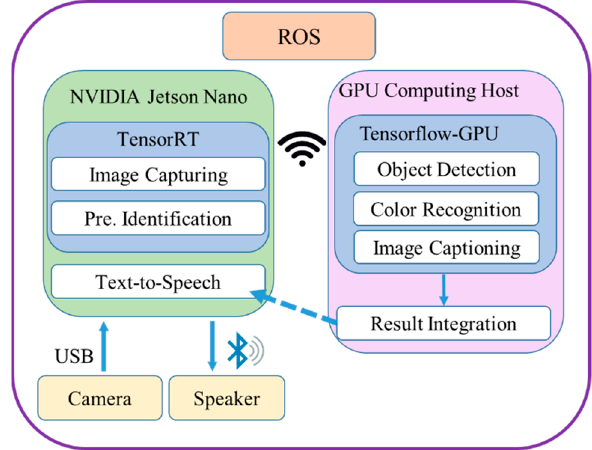
Figure 5. Proposed system architecture.